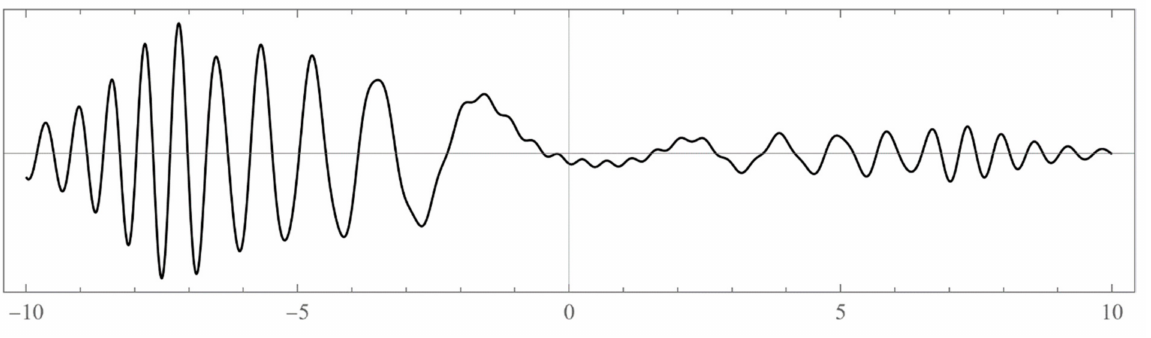
Figure A10. The un-normalized wavefunction (cid:101) ψ ( x , E ) for E = − λ 2 /2 in the left energy band. We took N = 100.